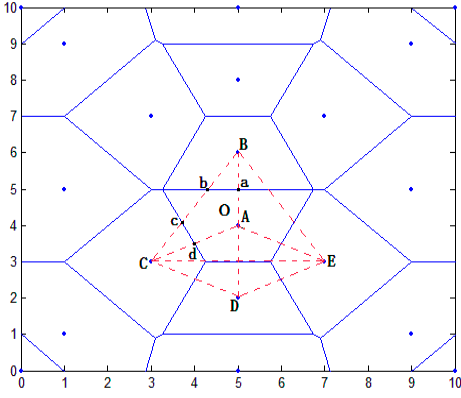
Figure 7. Unknown node in the positioning unit.